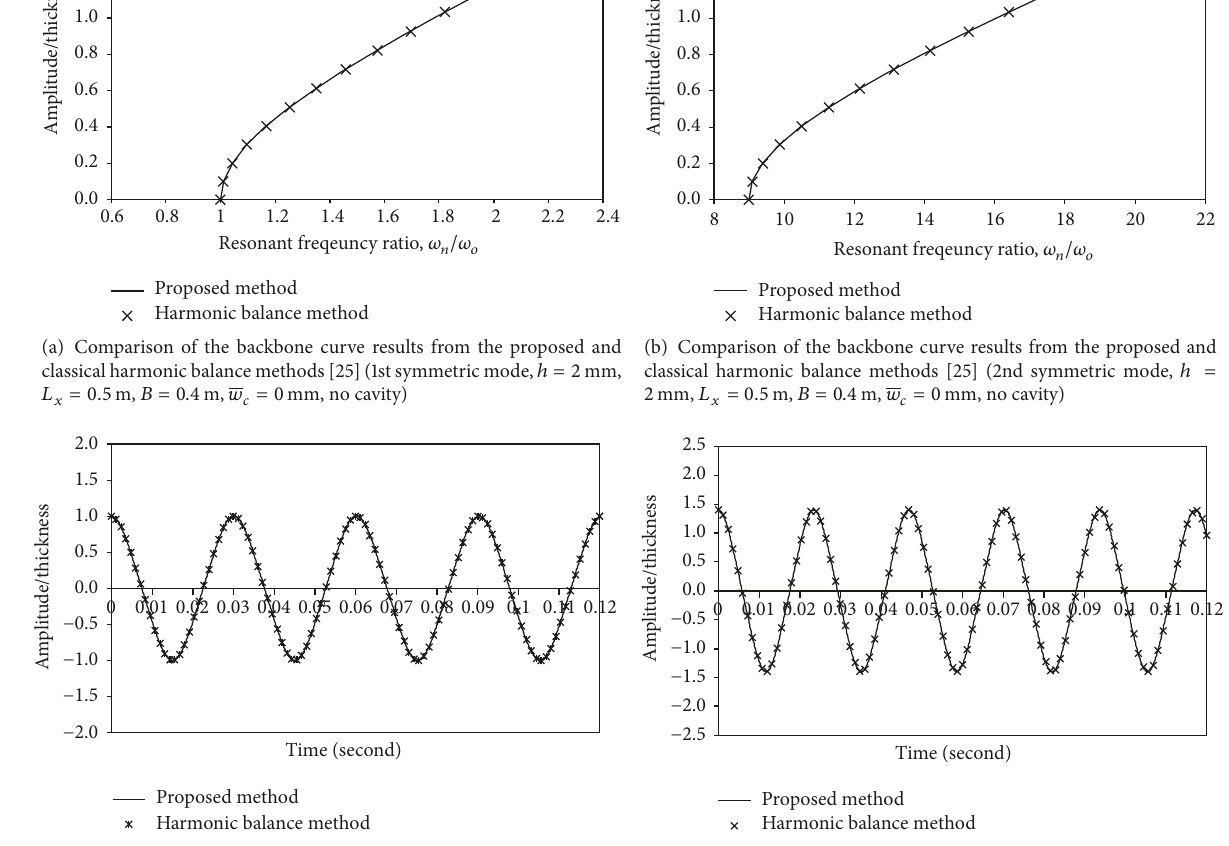
Proposed method Harmonic balance method